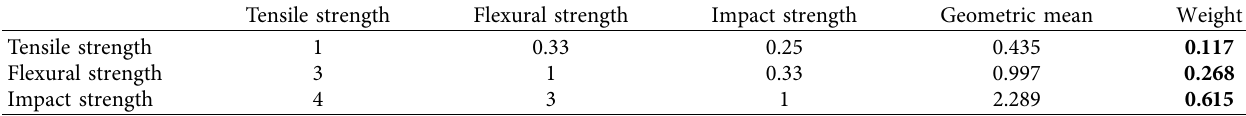
Table 4: Weights of mechanical properties through AHP.